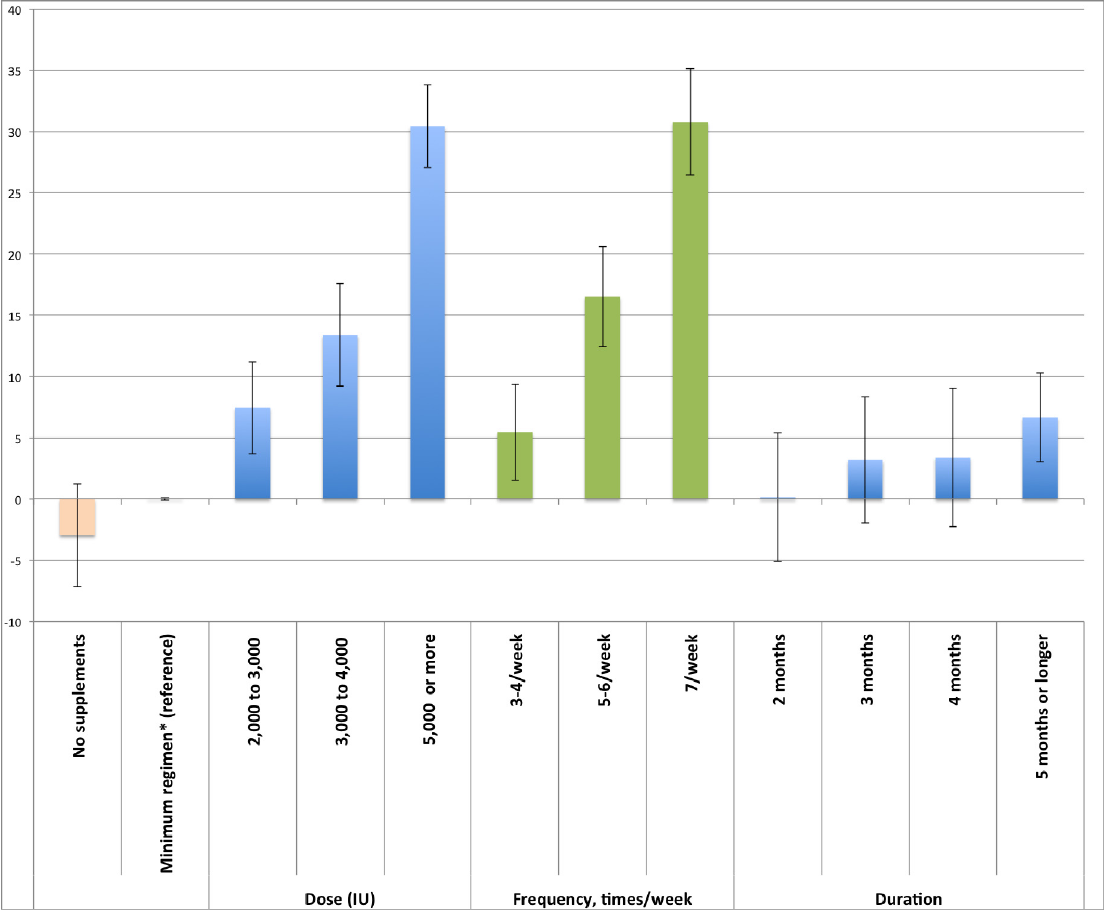
Figure 1. The dose responses between 25-hydroxyvitamin D levels and vitamin D supplementation based on the estimates from the multivariable regression